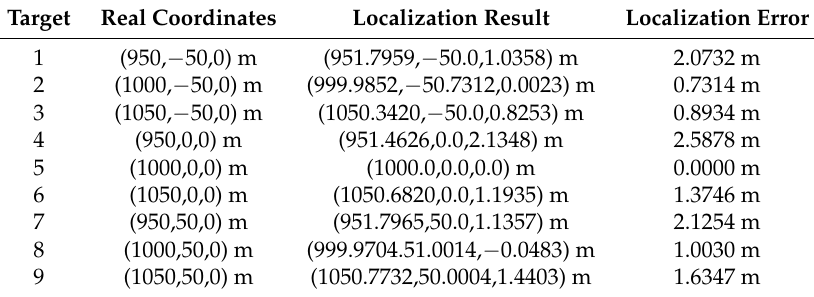
Table 8. Localization result with the three-dimensional